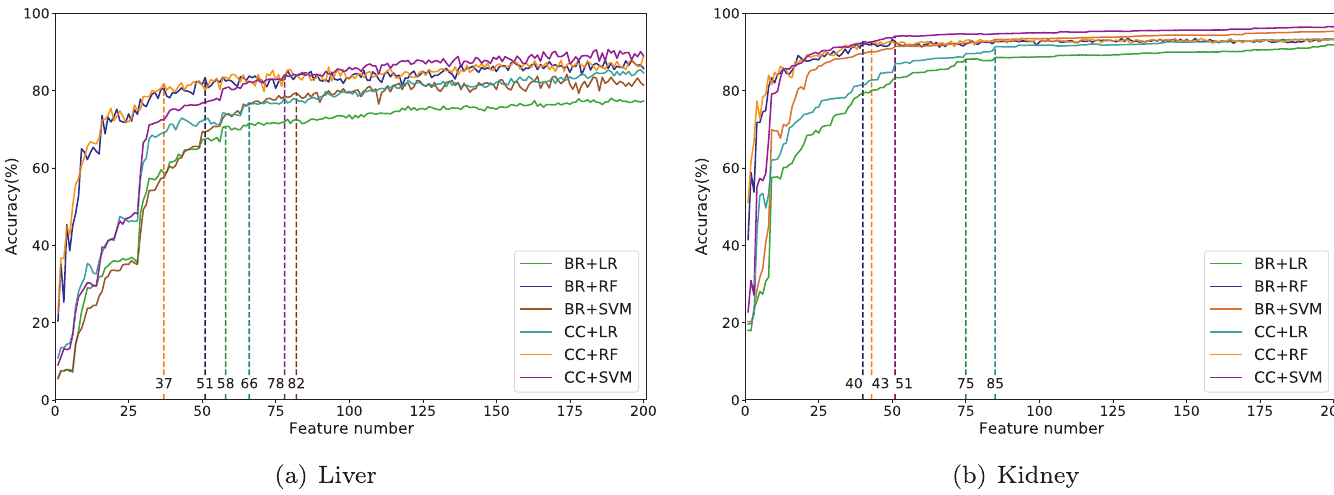
Fig 9. Intermediate results of selecting the optimal feature subset for BR and CC. The numbers of selected features are marked with dashed lines.